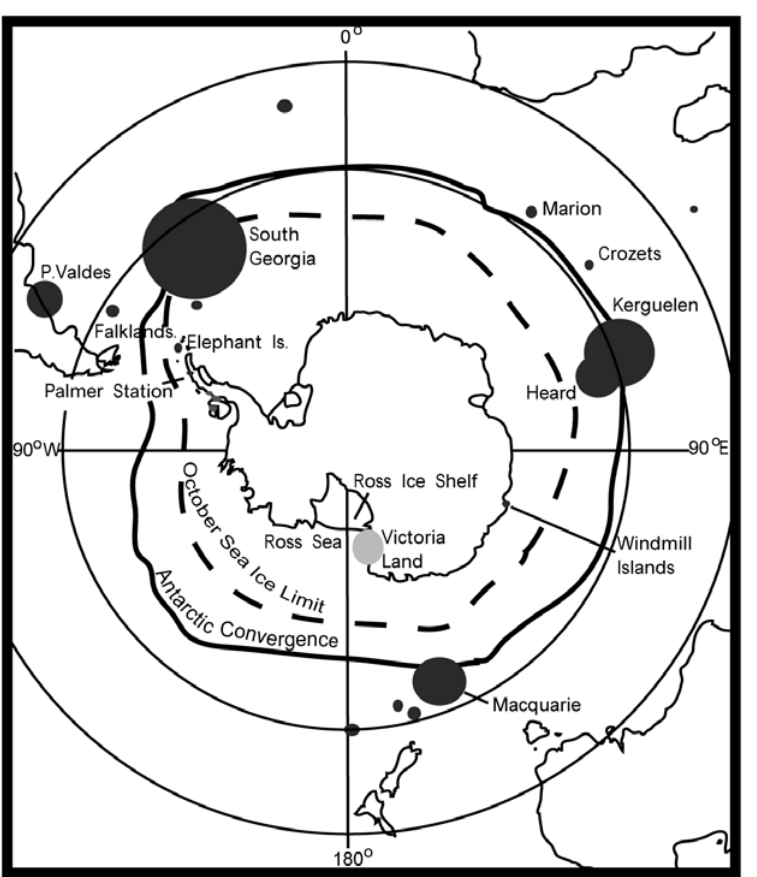
Figure 1. Map of study region showing major and minor southern elephant seal ( Miroungaleonina ) breeding colonies. With the exception of VLC (shown in gray), size of the circles indicates relative colony